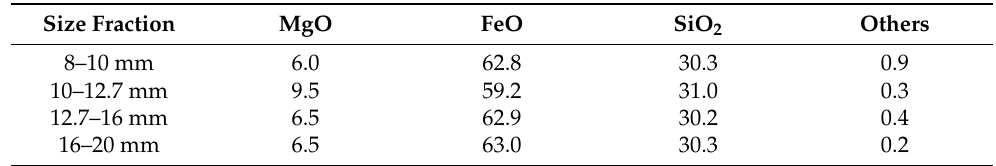
Table 5. Average compositions (in wt.%) for slag after the reduction-softening tests for different- sized pellets.